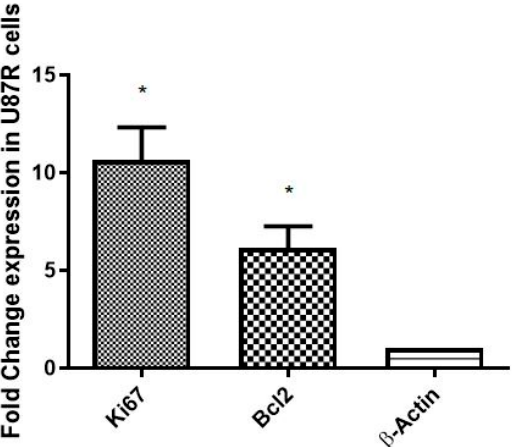
14 of 23 Figure 10. Fold change in expression of MGMT and STAT3 (resistance markers) in U87-S and U87- R. Each bar shows the mean ± SD values for each gene; experiments were conducted in triplicate. The results are normalized to β -actin, a housekeeping gene, and are expressed as a change from their respective controls. The level of significance is ** p ≤ 0.01, * p ≤ 0.05. 3.3.2. Assessment of Proliferation and Anti-Apoptotic Markers in U87-R